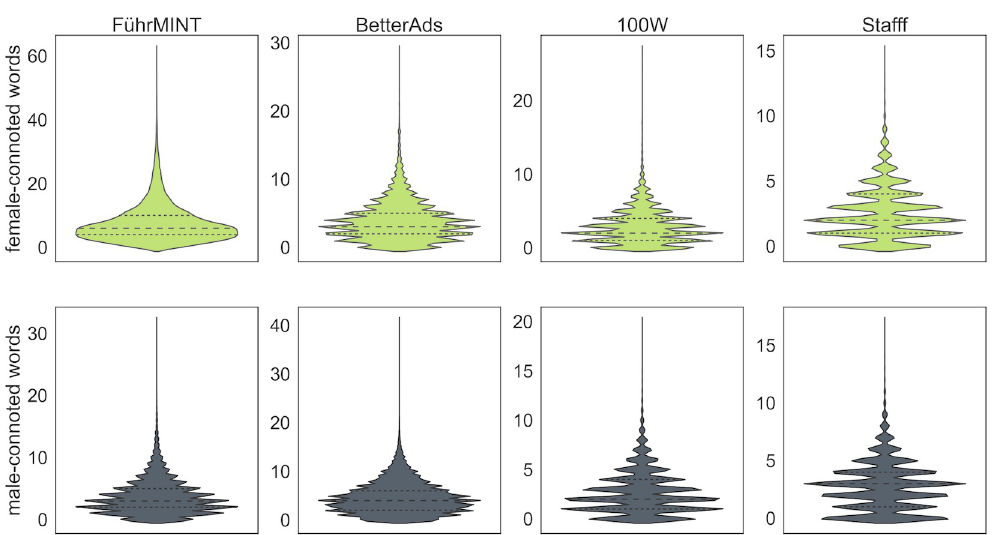
Fig 10. Distribution of the number of extracted feminine and masculine expressions per tool, showing the quartiles as dashed horizontal lines.